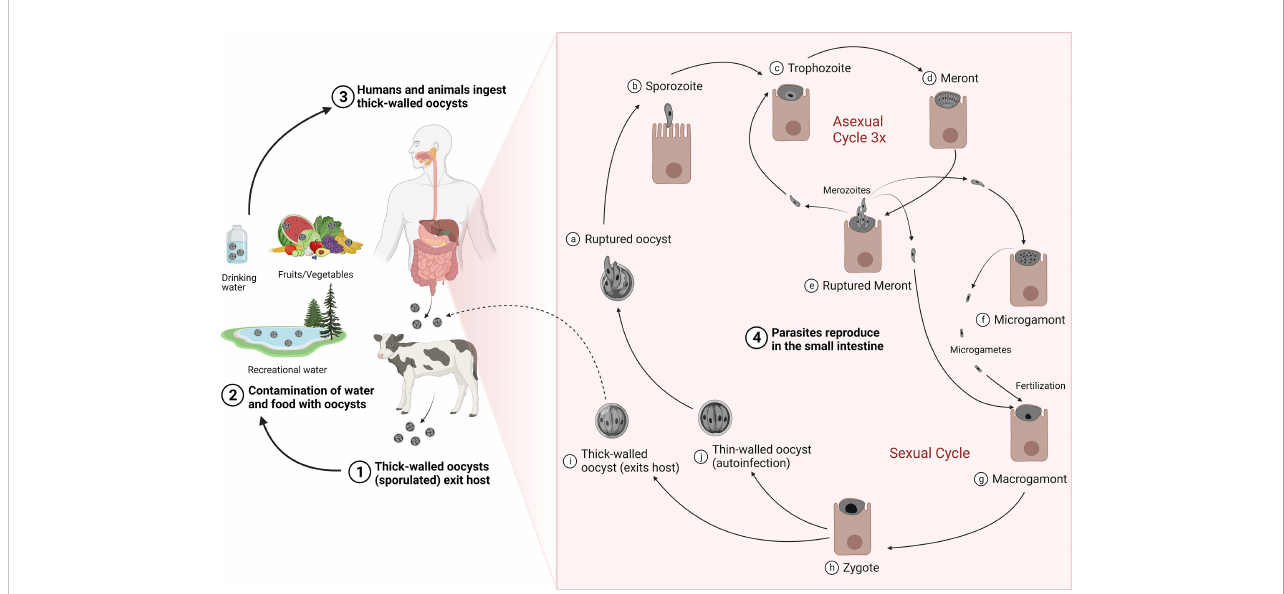
FIGURE 1 Life cycle and transmission of Cryptosporidium . Thick-walled sporulated oocysts are released in the feces of infected hosts (1) that contaminate food and water sources (2). Transmission occurs mainly by ingestion of contaminated water or food by susceptible hosts (3). Following ingestion, oocyst ruptures (4a) to release four sporozoites (4b). Sporozoites exhibit gliding motility, enter the host epithelial cells and mature into trophozoites (4c), which undergo three rounds of asexual multiplication to produce meronts (4d) that invariably release eight merozoites (4e). Merozoites released from the third round of asexual proliferation give rise to the sexual stages upon reinvasion of host cells: the male microgamonts (4f) and the female macrogamonts (4g). Microgametes released from the microgamont penetrate and fertilize macrogamonts to form diploid zygotes (4h). The zygotes undergo meiosis and sporogony generating either thin-walled (4i) or thick-walled (4j) oocysts, each containing four haploid sporozoites. Thick-walled oocysts are released into the lumen of the intestine and excreted into the environment, where they are instantly infectious. The thin-walled oocysts, in contrast, excyst to cause autoinfection in the same host. Adapted with modi fi cation from (CDC, 2019). Created with